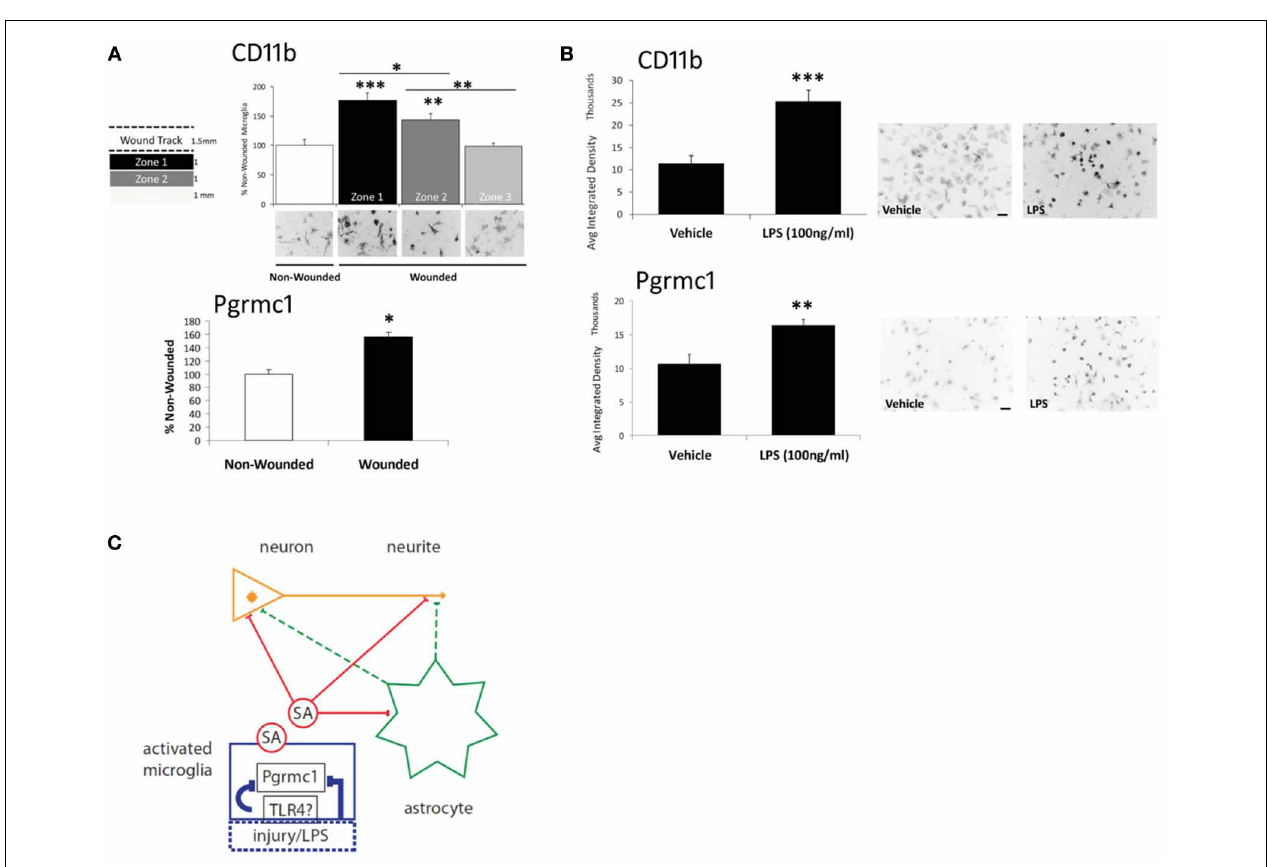
FIGURE 2 | Microglial activation via scratch wounding and LPS. (A) Microglial CD11b in 3 zones (1mm wide) progressively decreased distal to the wound. Pgrmc1 protein was also induced by scratch wounding. ∗∗∗ p < 0 . 0001; ∗∗ p < 0 . 03; ∗ p < 0 . 05 vs non-wounded. (B) CD11b and Pgrmc1 protein were both induced by by LPS. ∗∗∗ p < 0 . 0001; ∗∗ p < 0 . 001 vs vehicle. (C) Model to show targets of the undefined soluble activity (SA) from activated microglia and microglial Pgrmc1 that mediate the antagonism of P4 on E2-dependent neurite outgrowth. Microglial activation